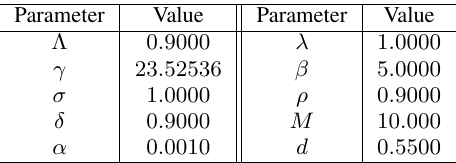
P ARAMETER VALUES USED IN F IGURES 6 AND